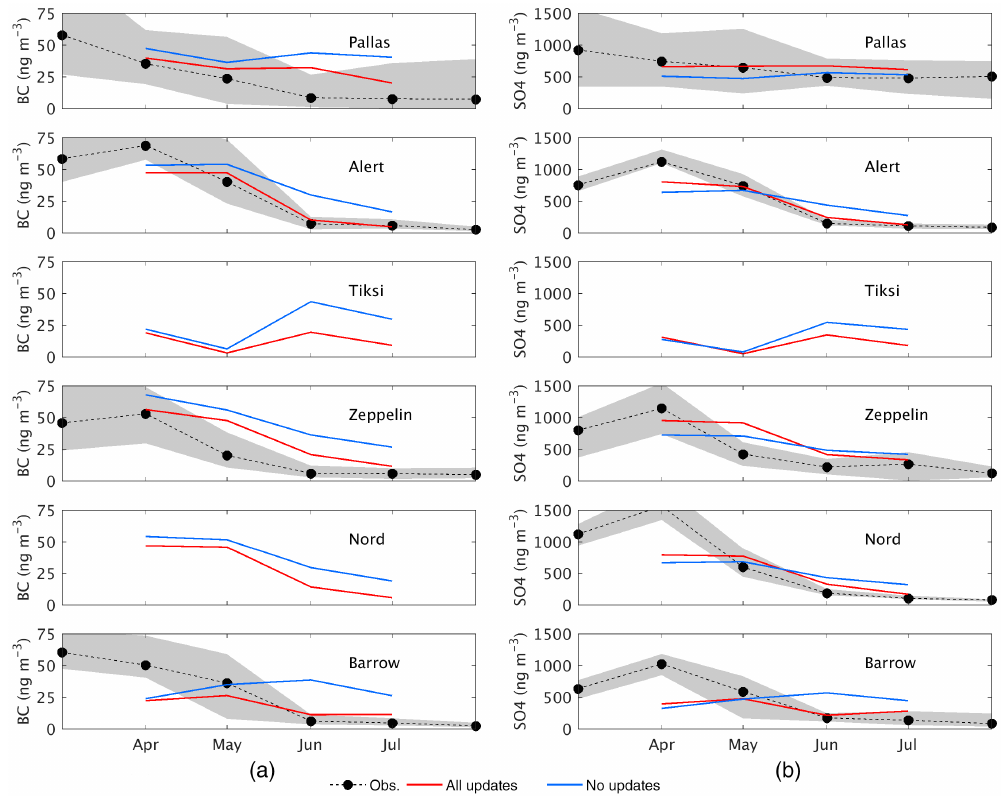
Figure 7. Monthly median BC (left) and SO 2 − (right) observations at Arctic surface stations (gray shading indicates 25th and 75th percentile) 4 and corresponding WRF-Chem results (red, ALL_UPDATES; blue,